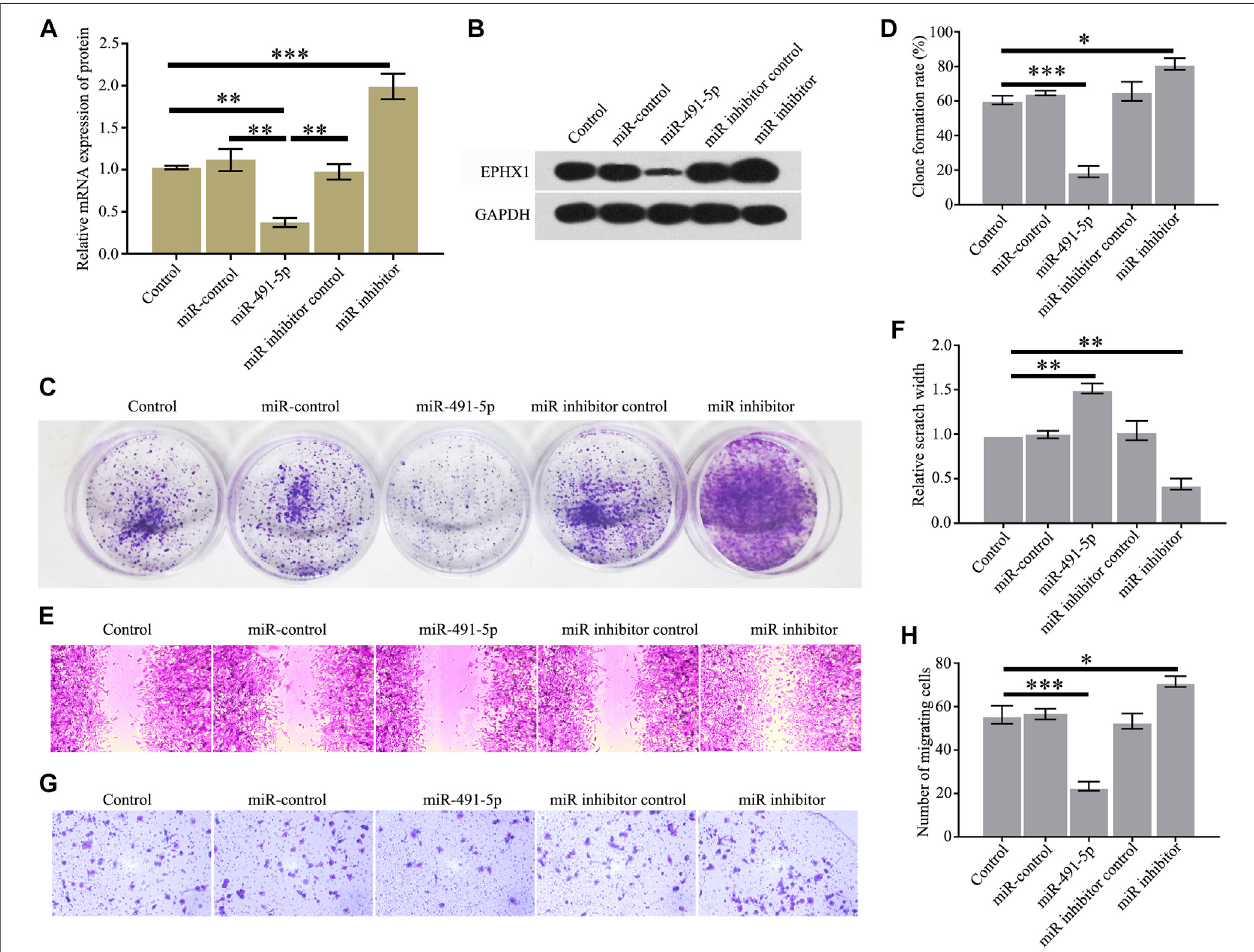
FIGURE 2 | Overexpression of miR-491-5p inhibited the expression of EPHX1 and the proliferation and migration of CRPC cells. After C4-2 cells were transfected withmiR-491-5p,theexpressionofEPHX1,proliferation,andmigrationofCRPCcellsweretested. (A) QRT-PCRassaywasusedtocon fi rmtheeffectofmiR-491-5pto the mRNA expression of EPHX1. (B) Western blot was used to evaluate the effect of miR-491-5p to the protein expression of EPHX1. (C,D) Cell colony formation experiment showed that miR-491-5p signi fi cantly inhibited C4-2 cell colony formation. (E,F) Cell scratch assay found that miR-491-5p signi fi cantly inhibited the migratoryabilityofC4-2cells. (G,H) TranswellassayshowedthatmiR-491-5p signi fi cantlyinhibited themigratoryabilityofC4-2cells.Dataareexpressedasthemean ± SD (* p < 0.05, ** p < 0.01, and *** p <